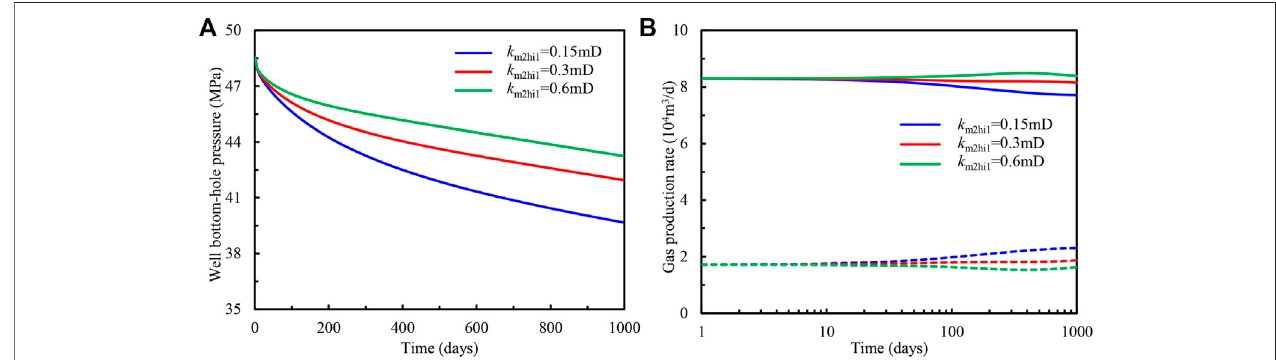
FIGURE 9 | In fl uence of horizontal permeability for matrix in the fi rst layer on (A) bottom-hole fl owing pressure and (B) gas production of individual formation.